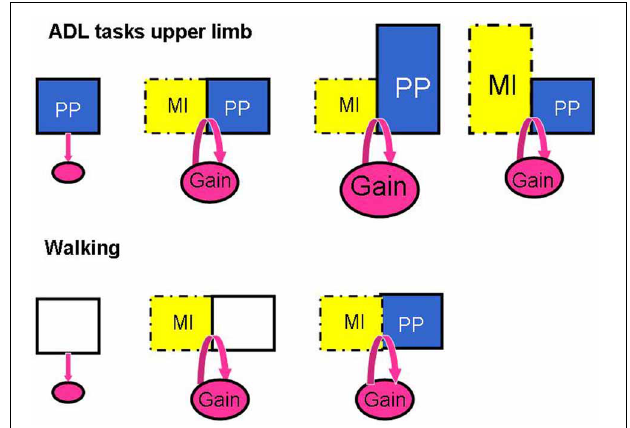
FIGURE 4 | Schema illustrating the patterns of responses when manipulatingtheamountofMItrainingandphysicalpractice(PP)inthe studies investigating the effects of MI interventions on ADL tasks of the upper limb and on walking. The addition of MI to PP promotes motor performance in ADL for the upper limb (Gain) and this performance is further enhancedwithmorePP,butnotwithlongerMIsessions;forwalking,however, MI alone promotes walking speed as much as MI plus treadmill